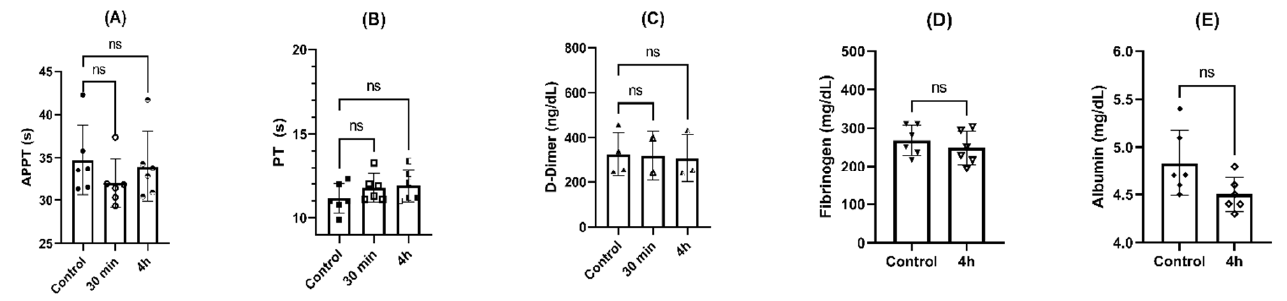
Figure 8. Effects of NPs on coagulation parameters after incubation for 4h at 37 °C: ( A ) activated partial thromboplastin time (APTT); ( B ) prothrombin time; ( C ) D-dimer levels; ( D ) fibrinogen; ( E ) albumin. ns = p > 0.05, ANOVA or paired t test (n = 6).